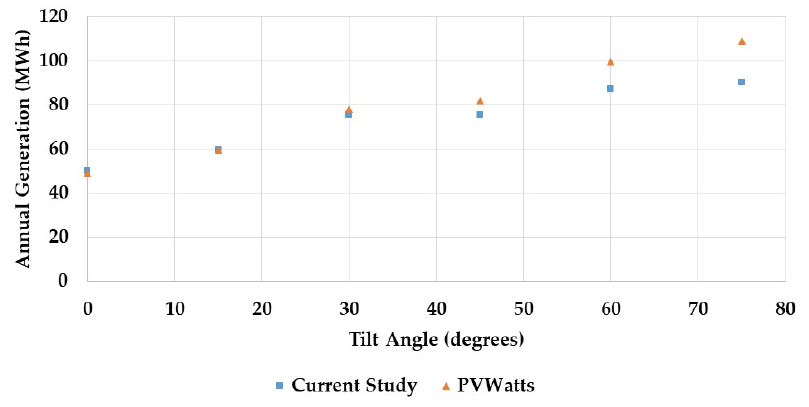
Figure 15. Comparison of annual generation obtained from code and PVWatts for the ADMIN building.